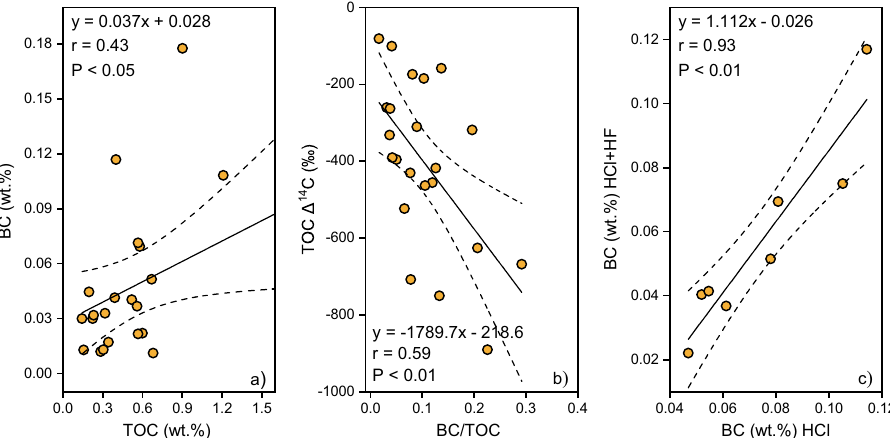
Fig. 2 Linear correlations for different types of carbon in surface sediments from six trench regions. a Total organic carbon (TOC) and black carbon (BC) contents. b TOC radioactive carbon isotopic composition ( Δ 14 C) and BC/TOC ratio. c BC contents with and without hydro fl uoric acid (HF)- treatments. The dotted lines are 95% credible